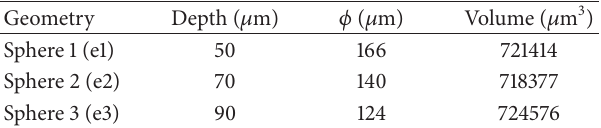
Table 1: Sphere geometry dimensions.